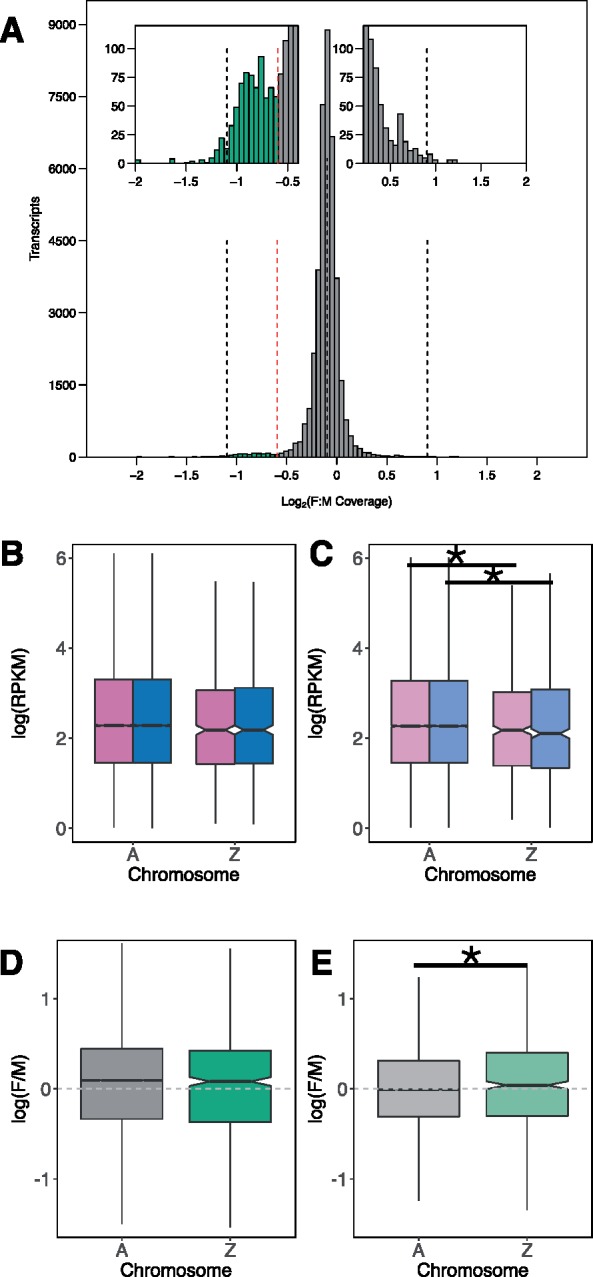
—Z chromosome identification and comparison of gene expression patterns with the autosomes. (A) Log2(Female:Male genomic coverage) of transcripts. Median log2(Female:Male coverage) shown as the central black dashed line. Median coverage ±1 are also shown as vertical black dashed lines. Cutoff for Z-chromosome coverage shown as dashed red line. Transcripts to the left of the dashed red line are assigned to the Z chromosome, and right of the dashed red line are assigned to autosomes. (B) Gene expression of females (pink) and males (blue) on the autosomes (“A”) and the Z chromosome (“Z”) in gonads. (C) Gene expression of females (pink) and males (blue) on the autosomes (“A”) and the Z chromosome (“Z”) in heads. (D) Female-over-male (“F/M”) expression ratios compared for the autosomes (“A,” gray) and the Z chromosome (“Z,” green) in gonads. (E) Female-over-male (“F/M”) expression ratios compared for the autosomes (“A,” gray) and the Z chromosome (“Z,” green) in heads. Wilcoxon test, *P value < 0.05, **P value < 0.01.